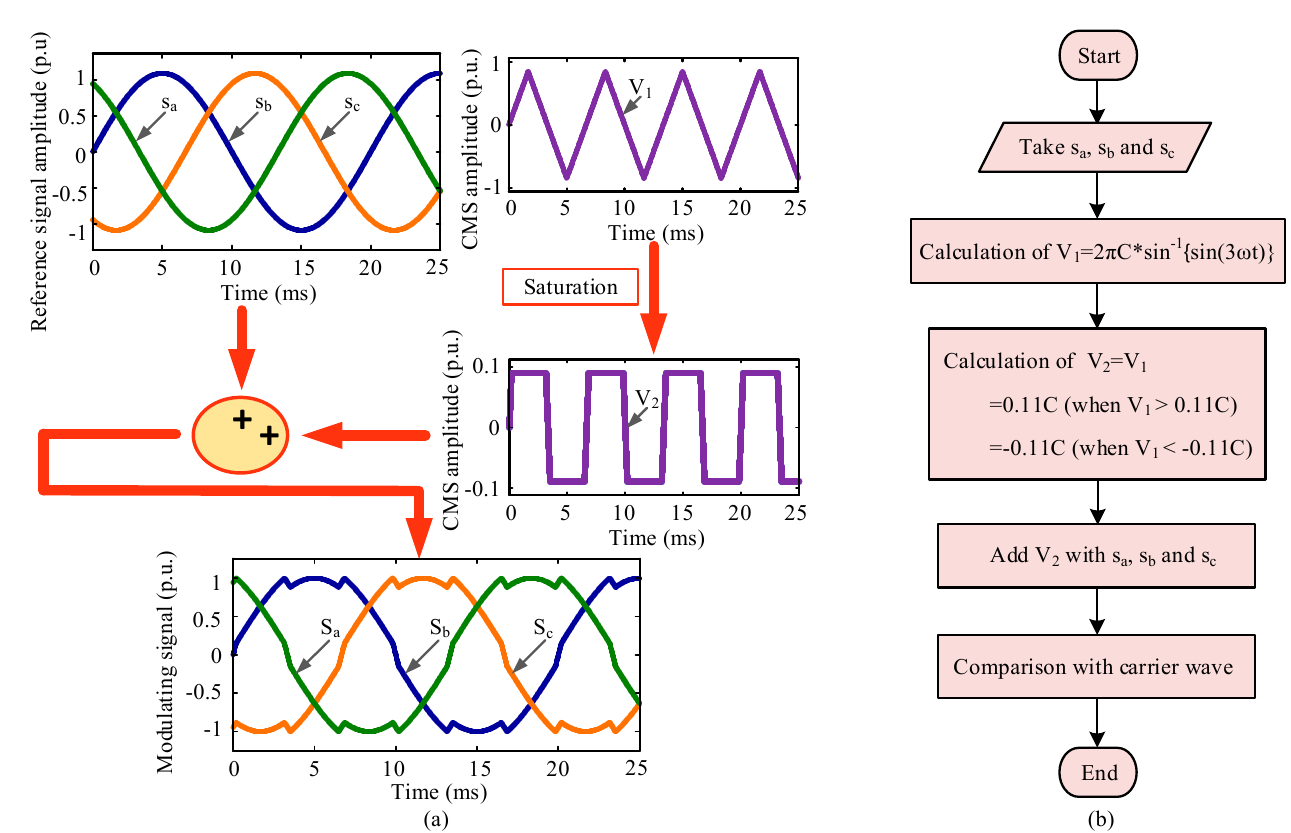
S c Figure 5. Proposed triangle saturated common mode pulse width modulation (TSCMPWM) mod- ulating signal. Figure 6a shows the generation of the proposed modulating signal. Here, in this fig- ure, s a , s b , and s c are the three phase sinusoidal signals, and can be expressed by Equations (1) – (3).